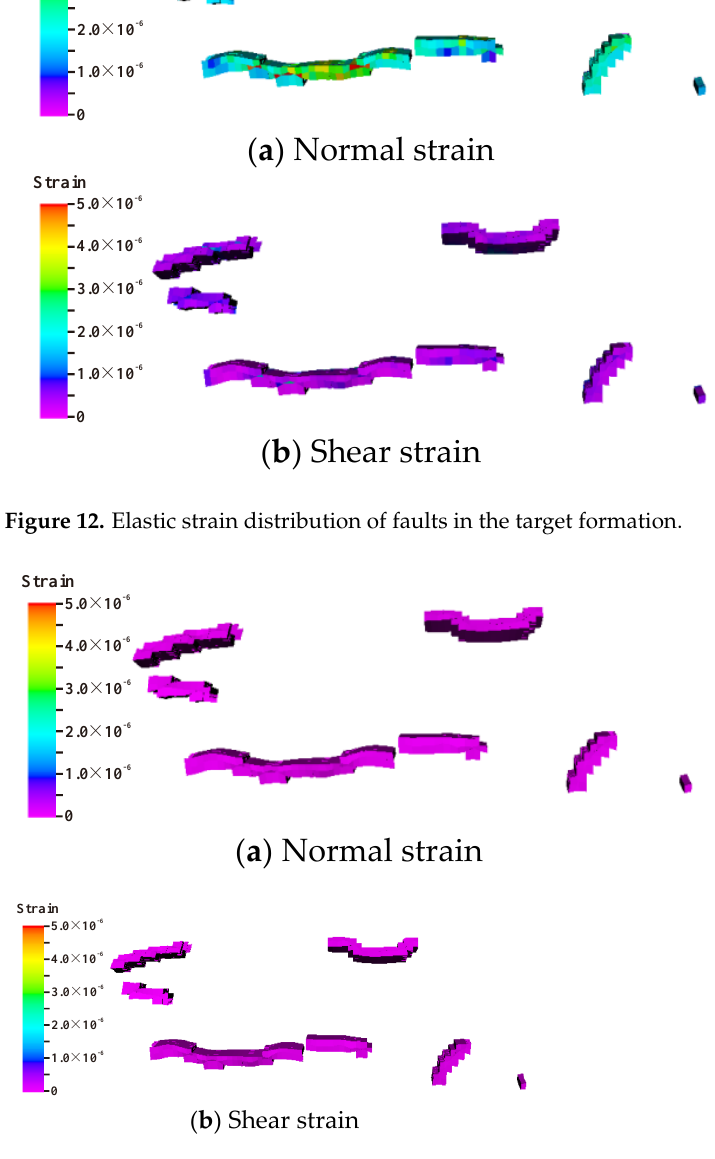
( b ) Shear strain Figure 14. Elastic strain distribution of natural fractures in the target formation. ( a ) Normal strain ( b ) Shear strain Figure 15. Plastic strain distribution of natural fractures in the target formation. 4.2. Analysis of Permeability Stress-Sensitivity Simulation Results The relationship between permeability and effective stress can reveal the mechanism of permeability stress-sensitivity in gas reservoir depletion development. Figure 16 shows the variation of normalized permeability and average effective stress ( σ o = ( σ x + σ y + σ z )/3) near the wells of LNY-06 and LNY-24 during gas reservoir development. The effective stress near the well increases and the permeability gradually decreases during depletion exploitation, exhibiting a high stress-sensitivity. Meanwhile, the figure shows the three- dimensional permeability of the fracture and matrix, with the greatest decay of permeability in the Z-direction of the fracture and the least decay of permeability in the Y-direction of the matrix.